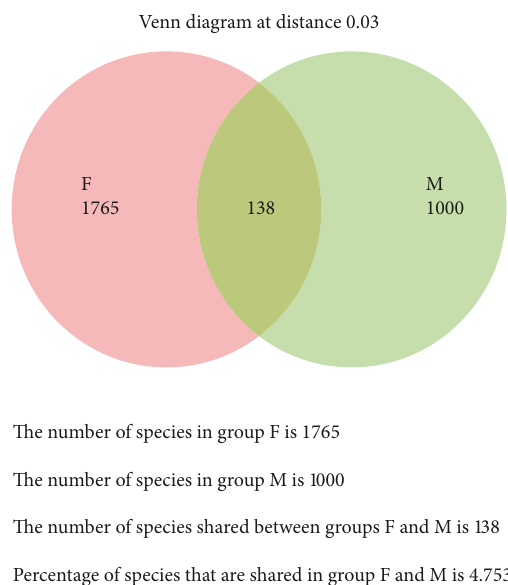
Figure 6: Rarefaction curves of 16S rRNA gene sequences for each sample calculated for OTUs at 97% similarity. Vertical axis shows operational taxonomic units, and horizontal axis shows the number of samples sequenced. OTUs = operational taxonomic units. Table 5: ∗ Derived from Kruskal-Wallis sum rank test. Bolded numbers are statistically significant ( 𝑝 < 0.05 ).